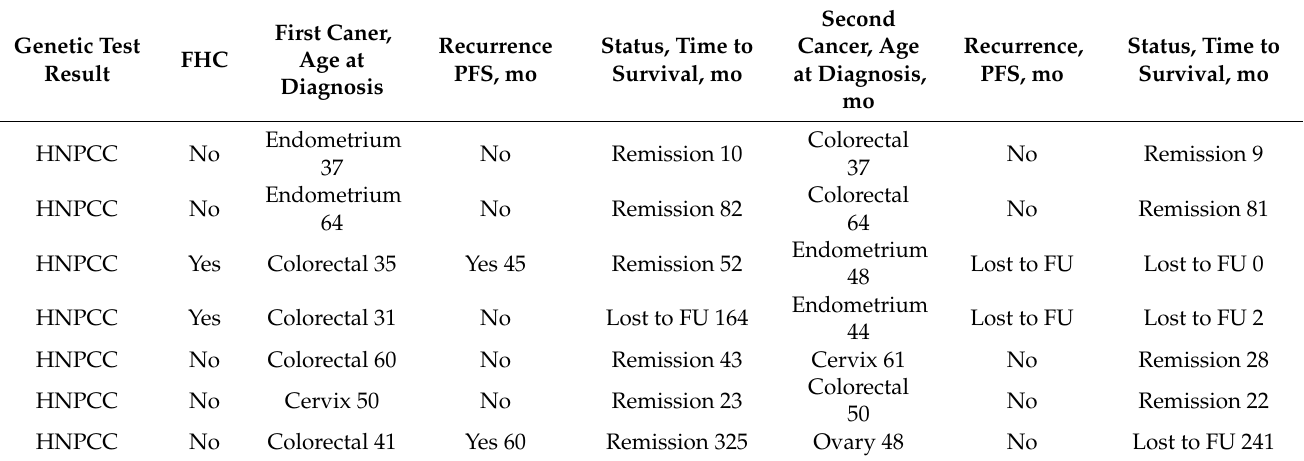
Table 3. Multiple primary malignancies in patients with gynecologic cancer with positive genetic test results ( n =